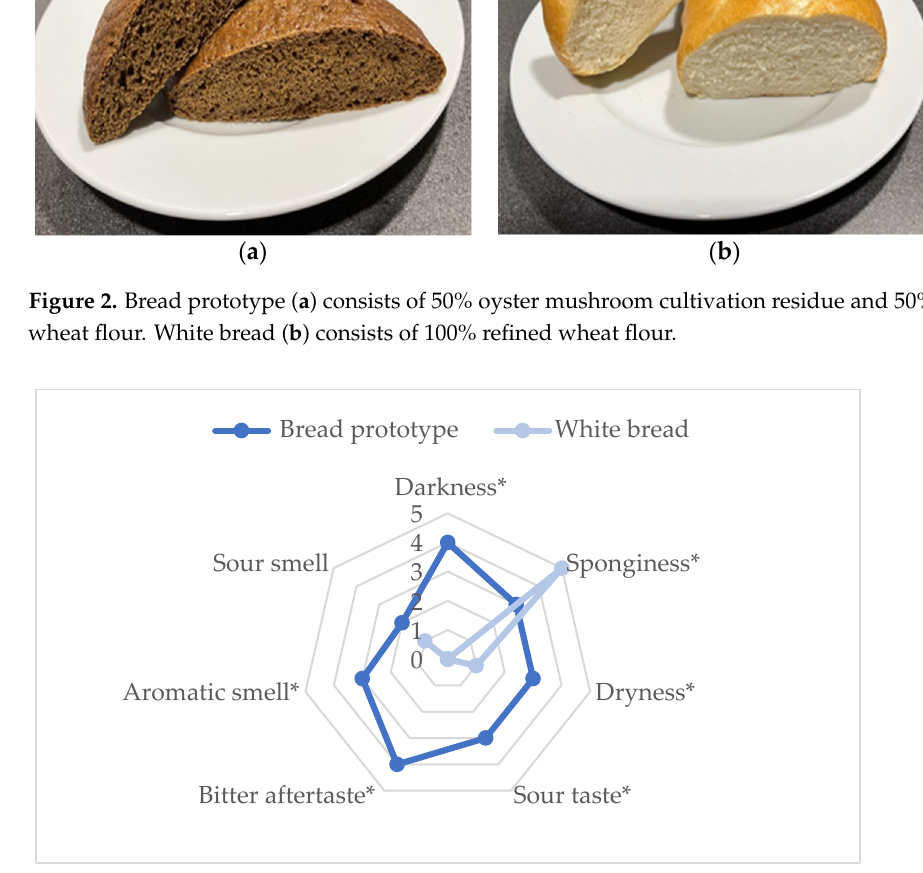
Figure 3. The median score for common sensory characteristics of the bread prototype and white bread ( n = 11). The scores were from 0 to 5 (0 = not present, 1 = very low, 2 = low, 3 = neither high nor low, 4 = high, 5 = very high). * Significant difference between bread prototype and white bread: p -value < 0.05.